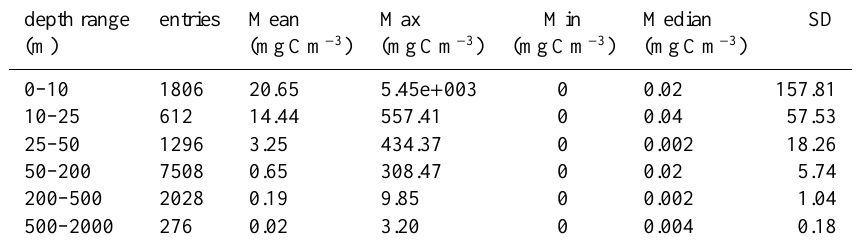
Table 5. Depth distribution of non-zero biomass values. Mean, maximum (max), median and standard deviation (SD) of biomass (mgCm − 3 ) per depth interval, calculated from non-zero data